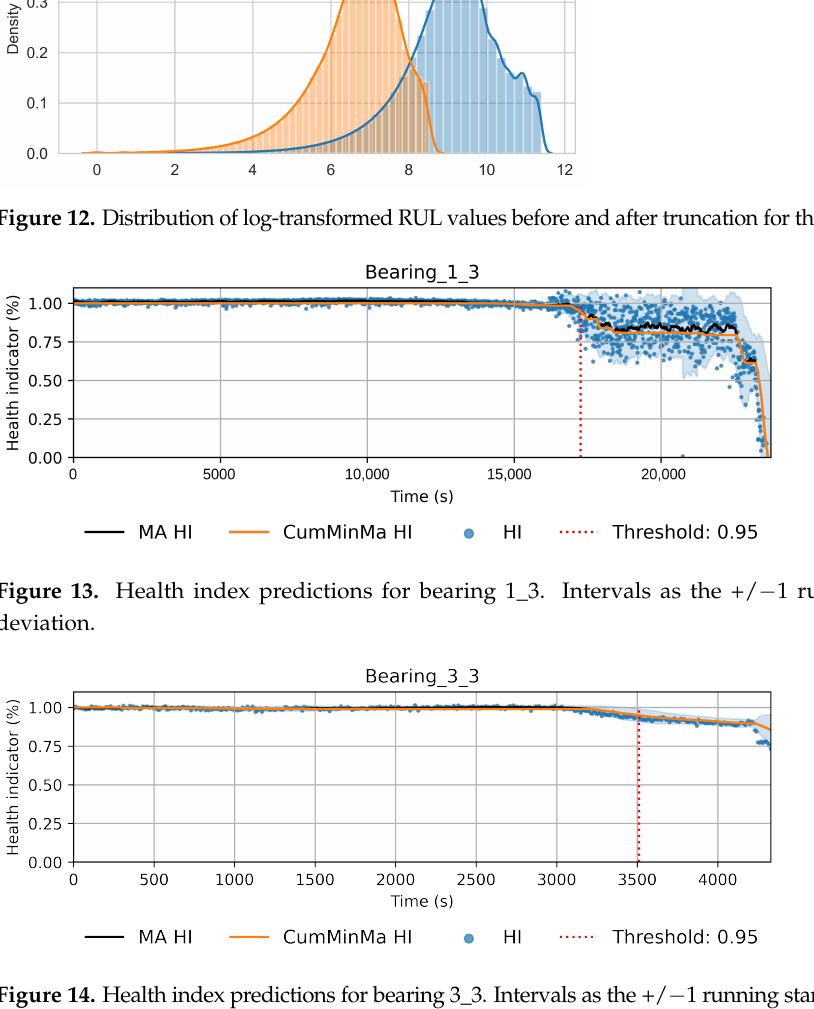
Figure 14. Health index predictions for bearing 3_3. Intervals as the +/ − 1 running standard